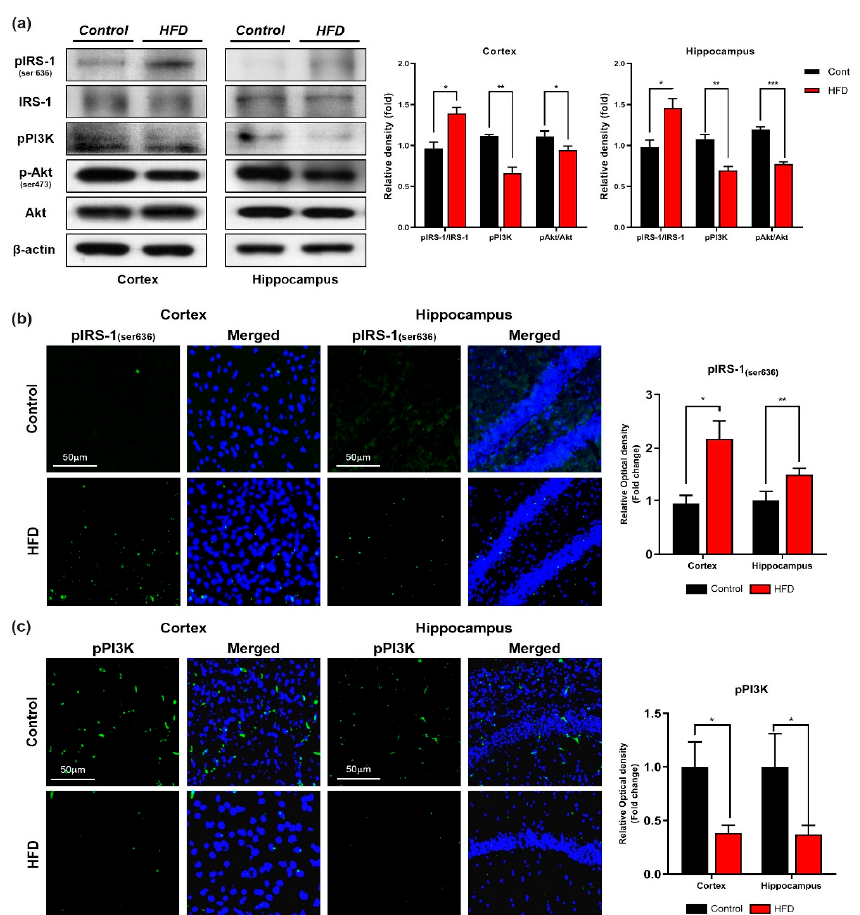
Figure 3. Chronic HFD reduced insulin sensitivity in HFD mice brains. ( a ) Immunoblot representation of insulin signaling pathway markers, phospho-insulin receptor substrate 1 (pIRS-1; 636), phospho-inositol 3-kinase (p-PI3K), and phospho Akt (p-Akt) along with their respective histograms. β -actin